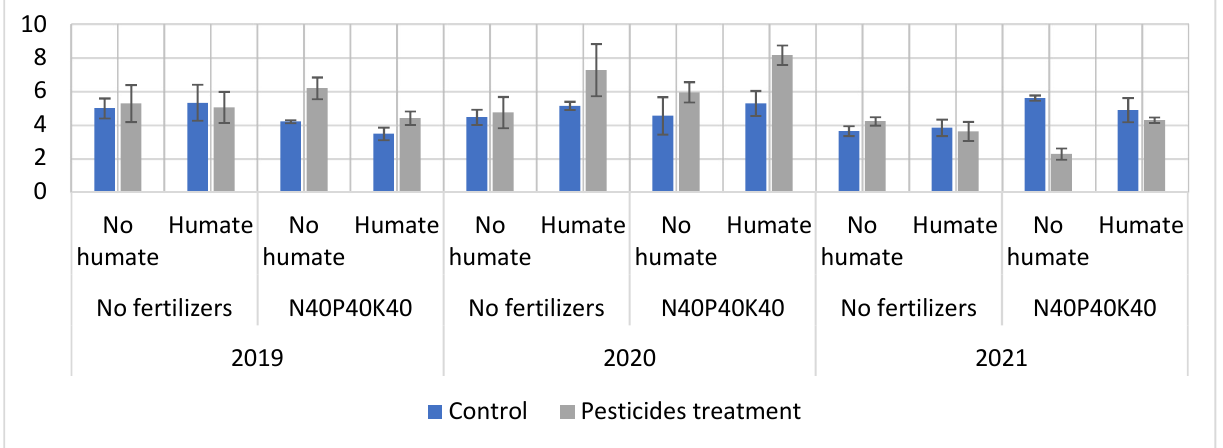
Figure 1. Dynamics of the structural coefficient in Calcic Chernozem under chickpea with the application of mineral fertilizers and a humic preparation on variants with and without pesticides.